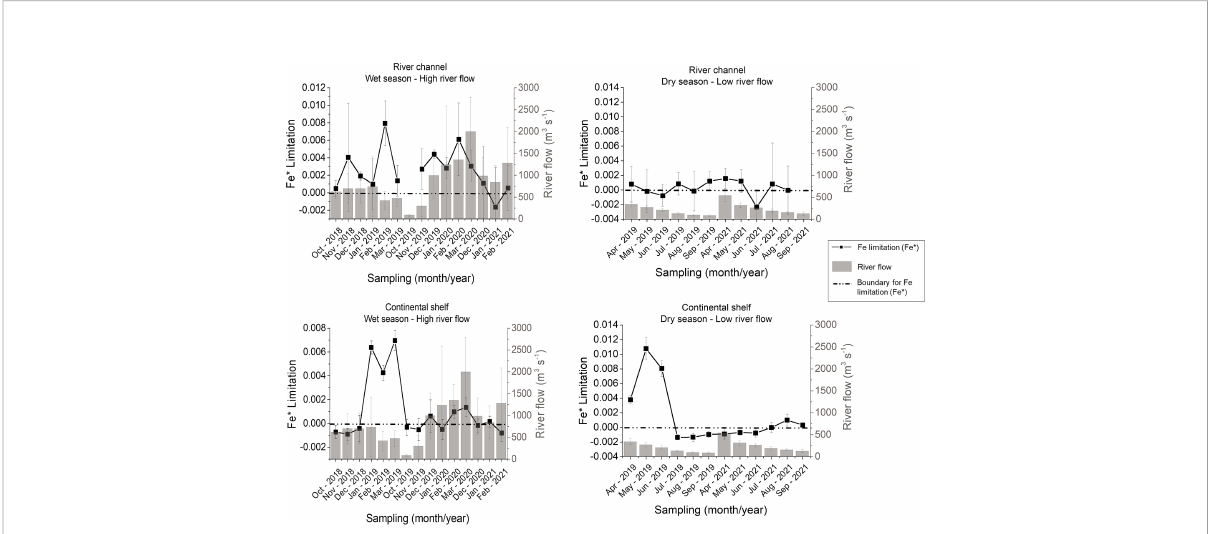
FIGURE 4 Plots of Fe* (P) in the Doce River channel and on the adjacent continental shelf during wet (high river fl ows) and dry seasons (low river fl ows). The black squares represent the Fe* limitation. The grey histogram represents the river fl ow in m 3 /s. Above the zero reference line (dotted line) DFe is available and below is